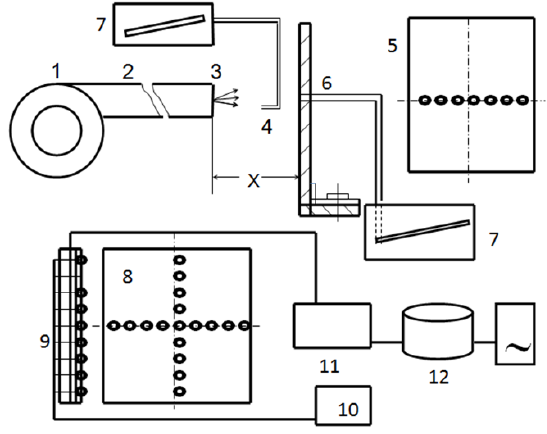
transfer rate of air jet impinging normally on flat plate.